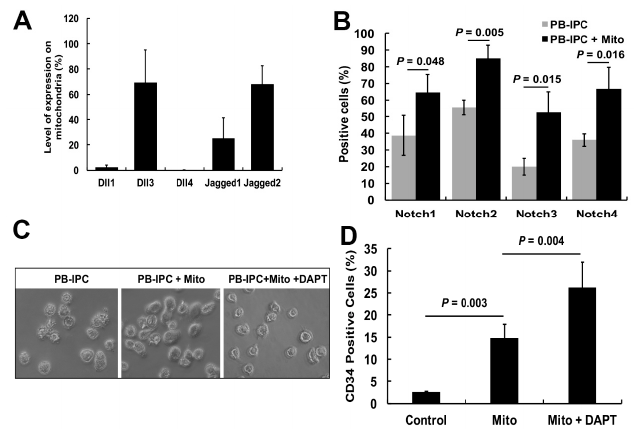
Figure 5. Notch pathway in the differentiation of PB-IPCs toward miCD34 + HSCs. ( A ) Analysis of Notch ligands on platelet-derived mitochondria by flow cytometry ( n = 3). ( B ) Expression of Notch receptors on PB-IPCs by flow cytometry. PB-IPCs were treated with mitochondria for 7 days and collected for flow cytometry. Untreated PB-IPCs served as control. n = 3. ( C ) Phase-contrast images show the morphology of PB-IPCs (left) and treated PB-IPCs in the presence of mitochondria (middle) and mitochondria + DAPT (right). Original magnification: ×200. ( D ) CD34 expression upregulation after the treatment with mitochondria and/or DAPT. DAPT-treated PB-IPCs served as control. n = 4. Data represent mean ± SD.